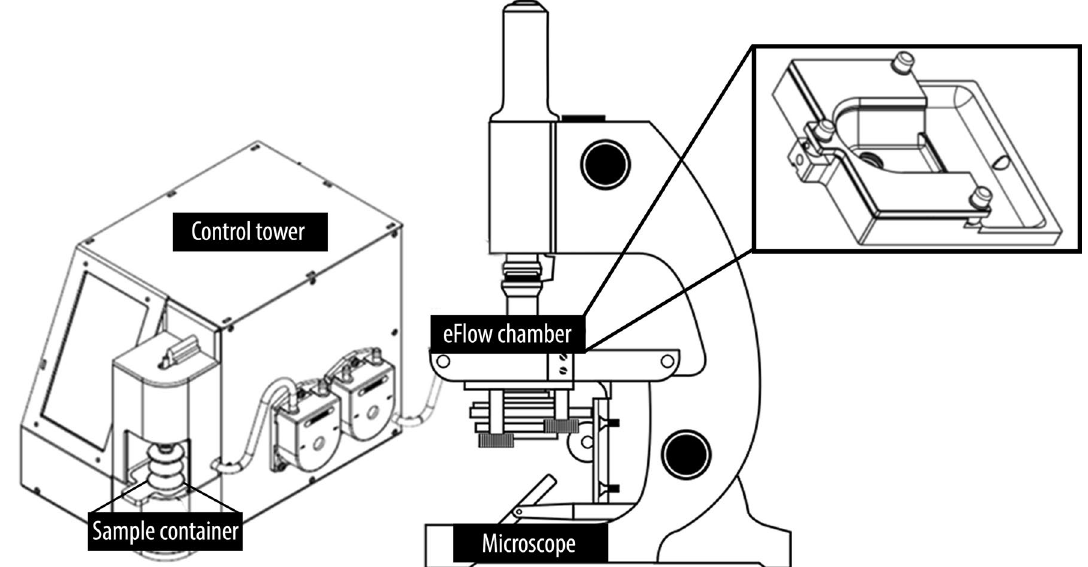
Figure 1. Overview of control tower with fluid management system and the eFlow chamber on a microscope stage. The pre-diluted sperm sample is automatically transferred from the sample container to the reusable eFlow chamber under the microscope objective. The microscope has a camera, which is connected to a PC with the ANDROVISION CASA (Minitüb) was used to pre-fill a sample container (Minitüb) with a Dispensette III (Brand GmbH). Thereaf- ter, 600 µL raw semen were taken from the middle of the glass container with an immersion depth of 1 cm (E4-2000XLS Pipette, Mettler-Toledo, Gießen, Germany) and added to the pre-filled sample container (dilution rate: 1 + 12 (v/v)), in order to reach the optimal range for sperm concentration analysis (150–550 sperm per analysis field), as recommended by the manufacturer. After that, the sample container was closed with a rubber plug and carefully turned overhead minimum 5 times to homogenize the diluted semen. The sample container was then put into the fluid-management system (FMS) and the sperm concentration was analyzed with the ANDROVISION CASA. The FMS of ANDROVISION eFlow automatically transferred the pre-diluted sperm sample in a closed system into the eFlow chamber by quenching the foldable sample container and simultane- ously taking up the sample in a silicone tube (inner diameter 3 mm, length 23 cm), which is connected to the eFlow chamber (Fig. 1). By this, the sperm sample is flushed into the measurement area of the chamber. The eFlow counting chamber includes a mechanism that allows to open the measurement gap to 500 µm in order to flush the sample into the measurement area. After filling the mechanism, closes the measurement gap to the preadjusted gap heights. The measurement area of the chamber consists of two parts, one with a height of 15 µm and a second part with a height of 30 µm. Sperm concentration was measured in the part with 30 µm height. The chamber height was controlled prior to performing the eFlow analysis with the gap measurement tool which is a photometry based gap measurement included in the eFlow system, in order to assure the correct chamber height. For determining the sperm concentration, the software ANDROVISION (Version 1.2) was used. The videos of the sperm samples in the eFlow were acquired with an Axioscope A1 (Carl Zeiss Microscopy GmbH, Oberkochen, Germany) and 10 × negative phase contrast objective. The microscope was connected to a Basler camera (Aviator avA1000-100gm, Basler AG, Ahrensburg, Germany), which was connected to the ANDROVISION-PC. During the measurement procedure, three measurement fields on the middle axis in each part of the eFlow chamber (15 µm and 30 µm gap) were accessed by means of an automatic scan stage that was mounted under the microscope and automatically controlled by the ANDROVISION software without user influence. Videos were recorded with a resolution of 0.3 megapixel and a frame rate of 60 Hz for 0.5 s. The recorded measurement area in each measurement field was 512 × 512 µm. For sperm concentration measurement, three fields were recorded in the 30 µm gap area. Experiment 2: Comparison of NUCLEOCOUNTER, ANDROVISION eFlow and ANDROVISION with Leja chambers for concentration analysis in diluted semen samples. To compare the concentration measurements of different methods, 109 diluted boar semen samples from a commercial AI center were measured for sperm concentration with the NUCLEOCOUNTER, ANDROVISION eFlow and ANDROVISION with dispos- able counting chambers (Leja, 4-chamber counting slides; 20 µm nominal chamber depth, Leja Products B.V., Nieuw-Vennep, The Netherlands) in a split sample design. The semen tubes were randomly taken during the daily production of the AI center. The target sperm content per semen tube was 1.8 billion sperm. All boar semen samples were tested in double measurements and the coefficient of variation (CV) was calculated for each sample and each method. All semen samples were obtained in 85 mL Quicktip Flexitubes (Minitüb) and pre-warmed